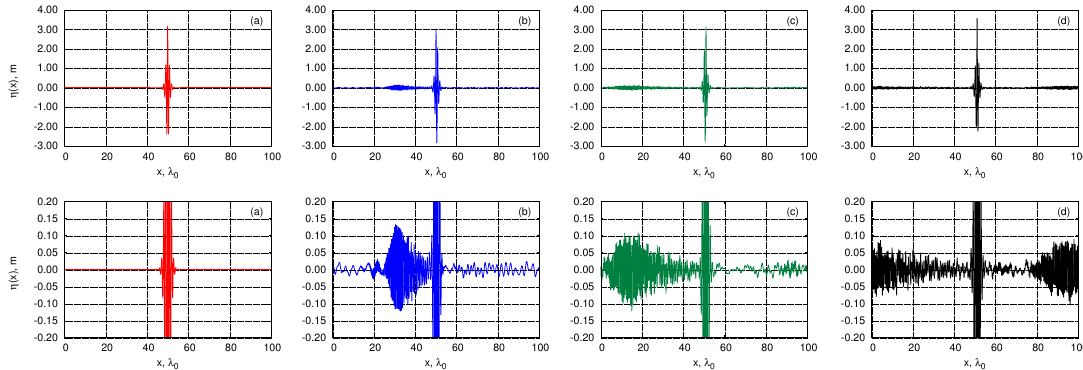
Figure 1. Propagation of single breather with the wave steepness µ ≈ 0.25 in the fully nonlinear model. The initial condition in physical variables was restored with the first order accuracy from variables of the Zakharov equation. ( Top ) row: the surface elevation η ( x ) at different subsequent moments of time. Panel ( a ) shows the initial surface profile (at t = 0); panel ( b ) corresponds to t = 1067 s ≈ 133.3 T 0 ; thepanel ( c ) corresponds to t = 2134 s ≈ 266.6 T 0 ; and thepanel ( d ) corresponds to t = 3201 s ≈ 400 T 0 ( Bottom ) row: zoom of the top row